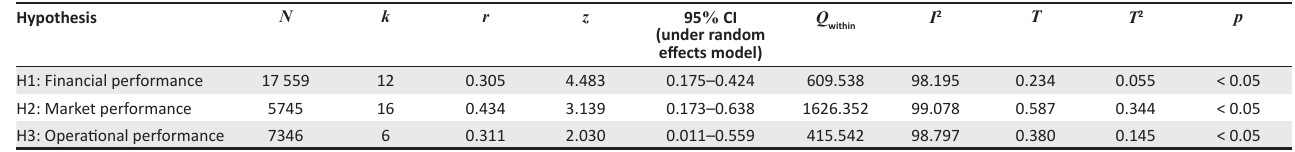
TABLE 1: Meta-analysis results. Hypothesis